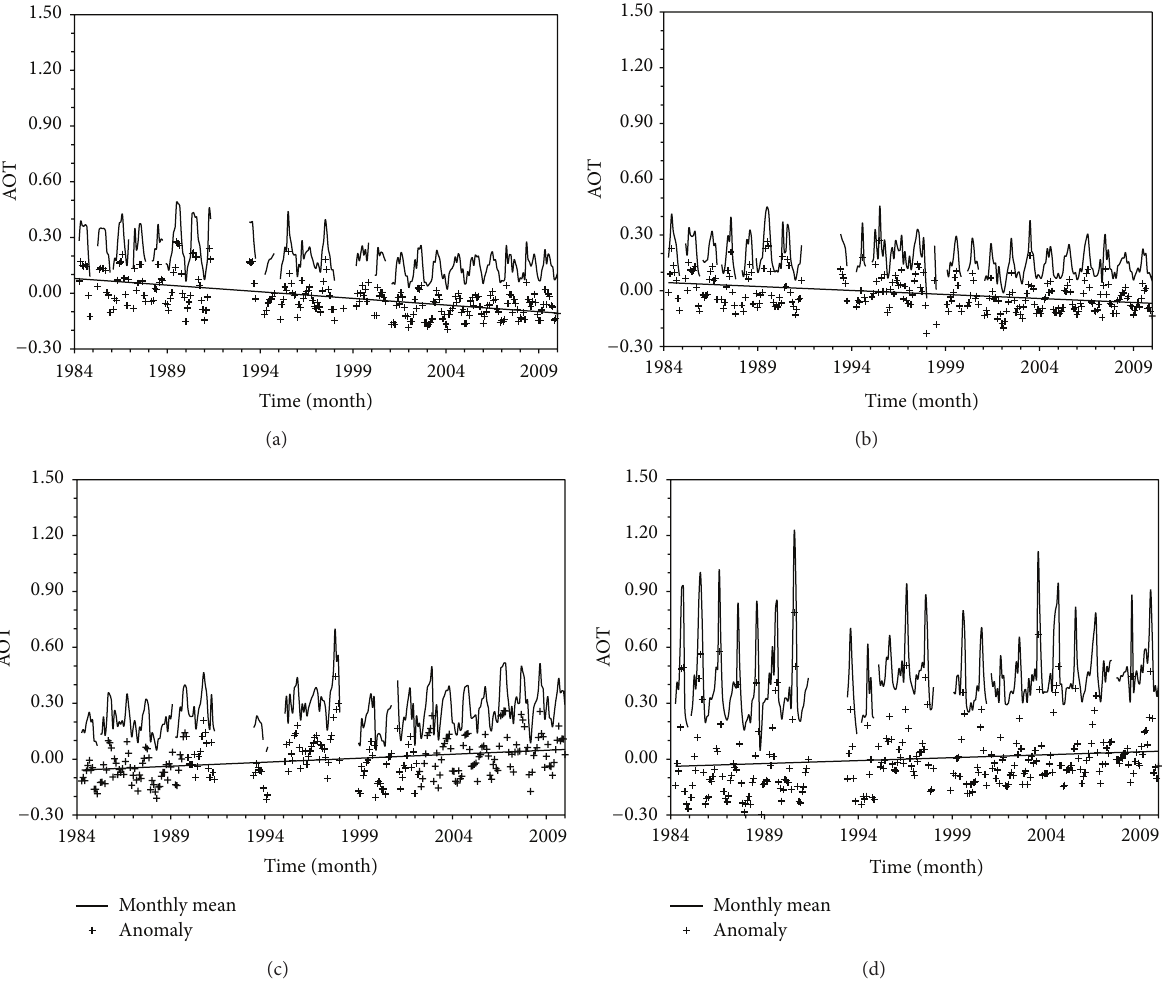
Figure 3: Examples of time series (dark curve) of monthly mean AOT for (a) Istanbul, (b) New York, (c) Jakarta, and (d) Mumbai. Plus symbols are the departure (or anomaly) from the climatology and the linear trend is shown as the dark straight